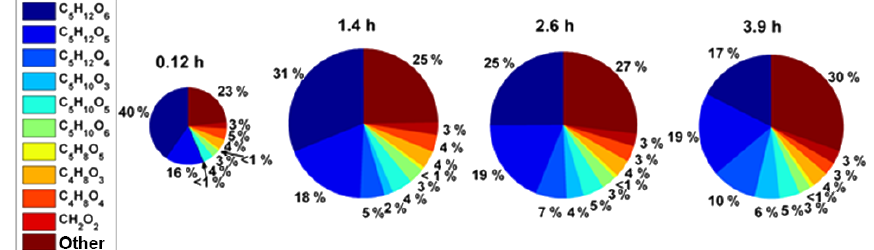
Figure 4. Time evolution of particle-phase concentrations in a batch mode isoprene photochemical oxidation experiment at low NO x . Time increases from left to right and the size of the pies is proportional to the amount of OA present, which is 5.6, 10.8, 10.6, and 10.4µgm − 3 from left to